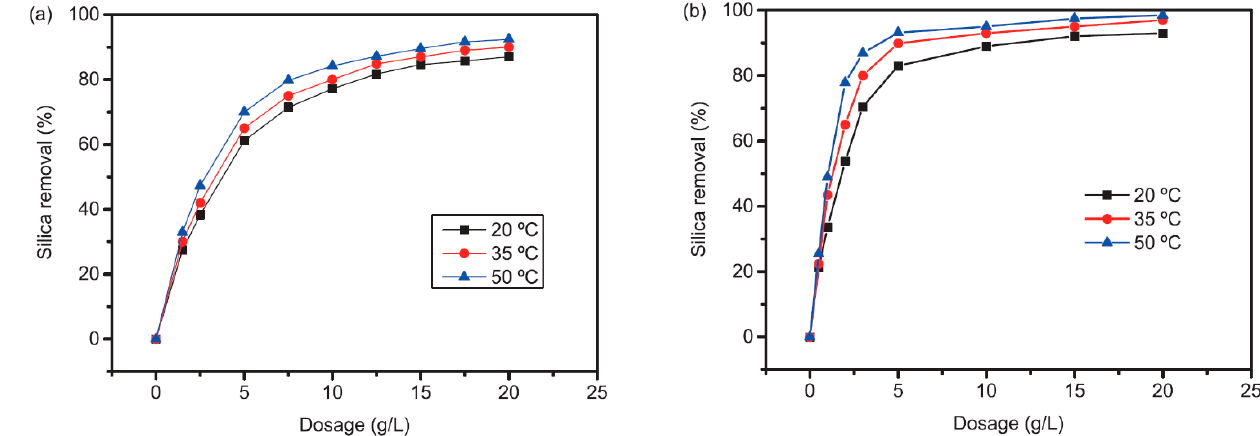
Figure 11. Effect of temperature on silica removal by ( a ) pseudoboehmite and ( b ) γ -Al 2 O 3 at different adsorbent dosages (initial pH 8.5, 16 h contact time).